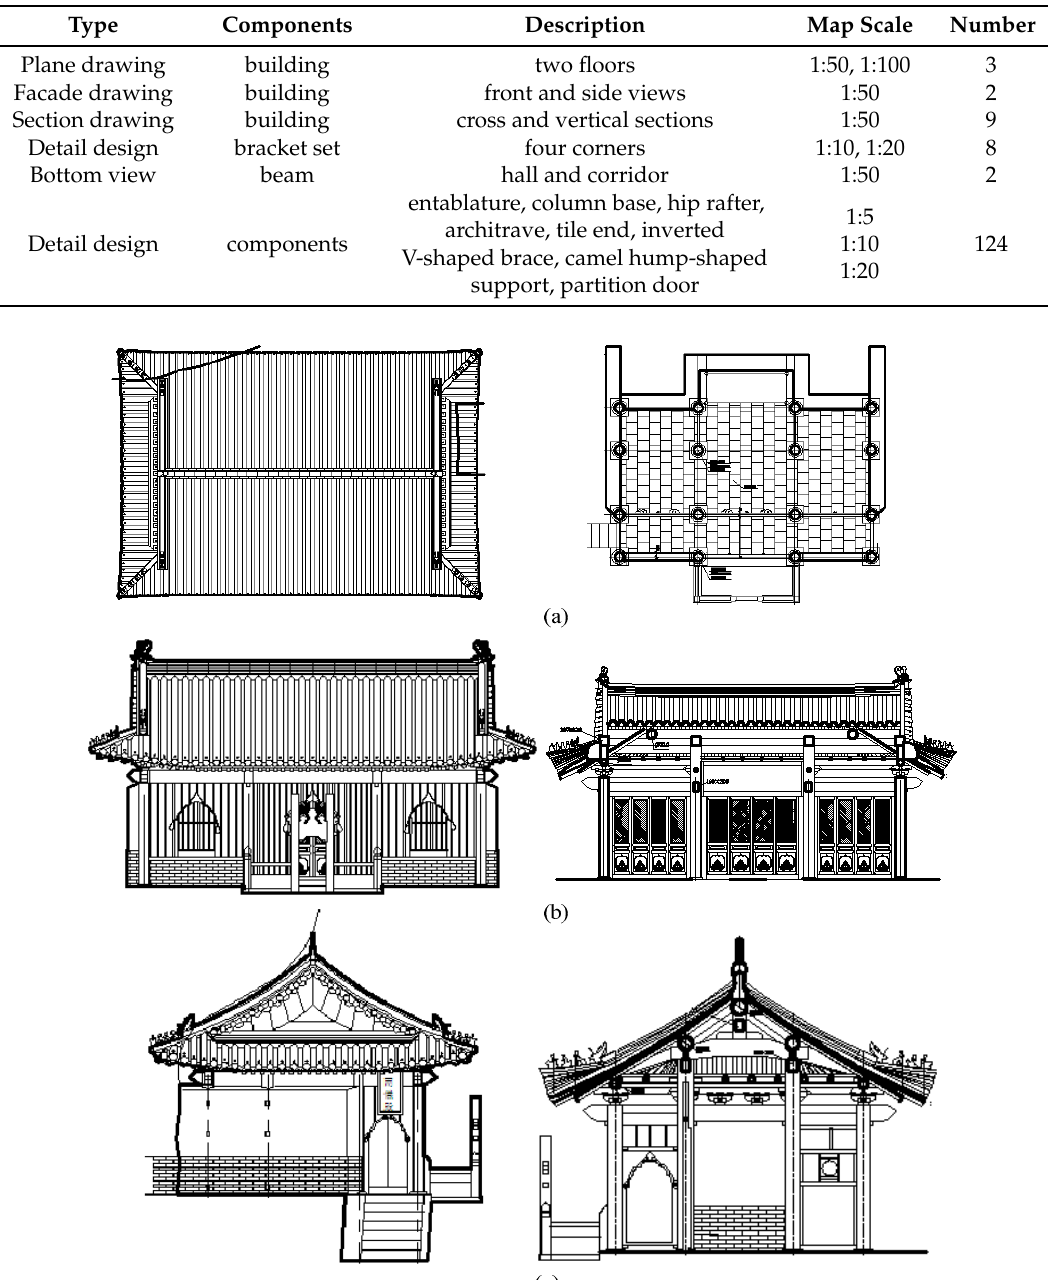
Figure 15. Cont. Figure 15.